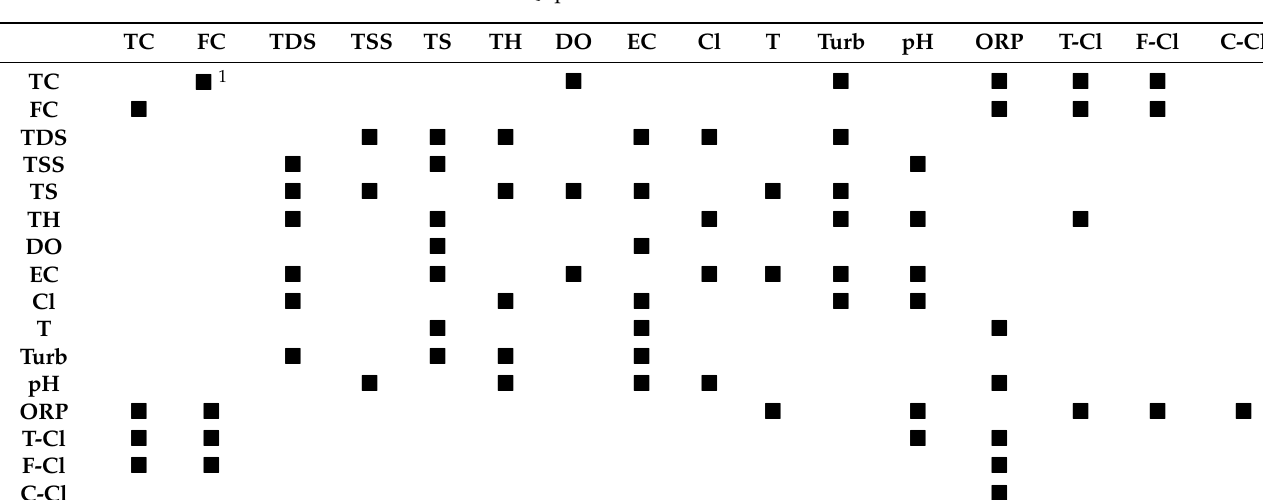
Table 2. WQI parameters